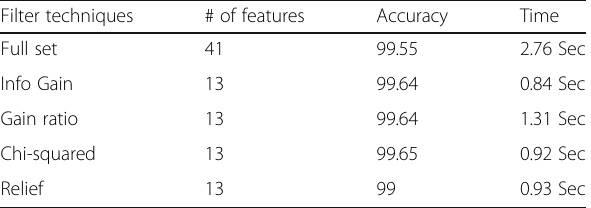
Table 14 Detailed accuracy for C4.5 Decision tree classifier with different feature sets